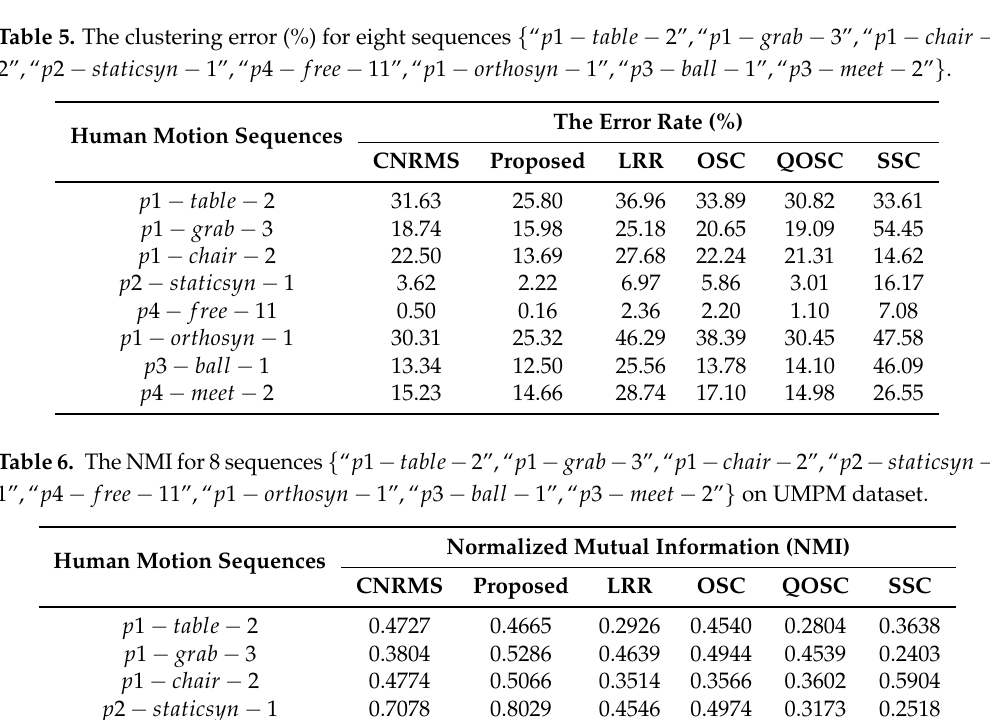
Table 5. The clustering error (%) for eight sequences { “ p 1 − table − 2”,“ p 1 − grab − 3”,“ p 1 − chair −